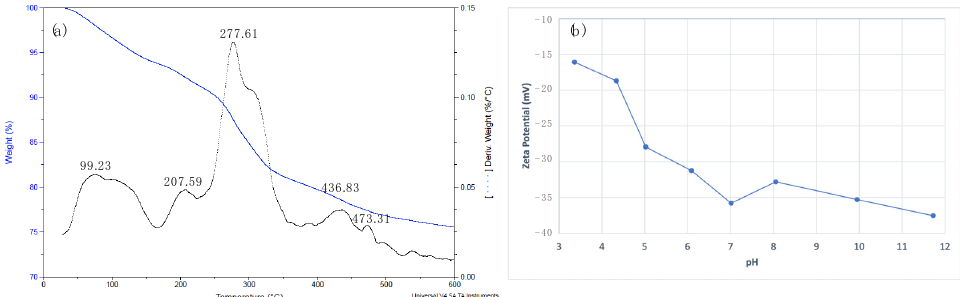
Figure 4. ( a ) TGA diagram of Phy@Fe 3 O 4 nanoparticles under nitrogen atmosphere. ( b ) z-potential obtained for the Phy@Fe 3 O 4 nanoparticles at different pH.